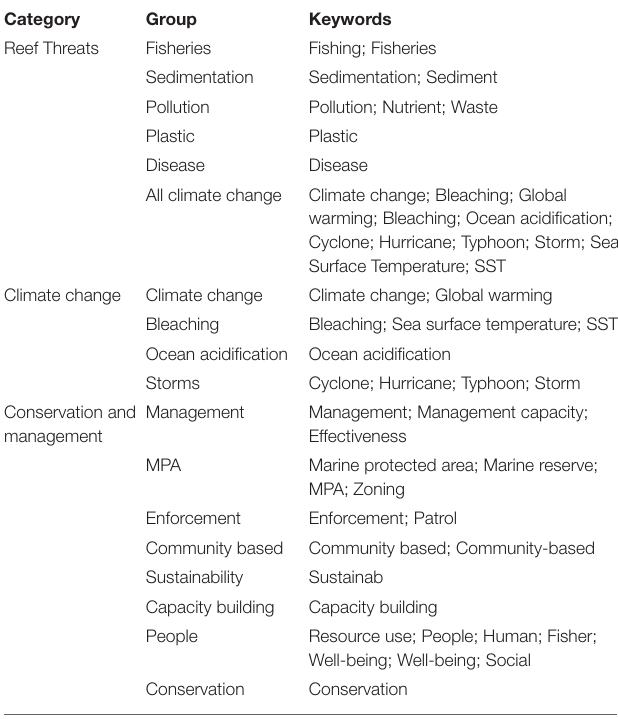
TABLE 1 | Keywords used to identify changes in frequency of different topics presented. Category